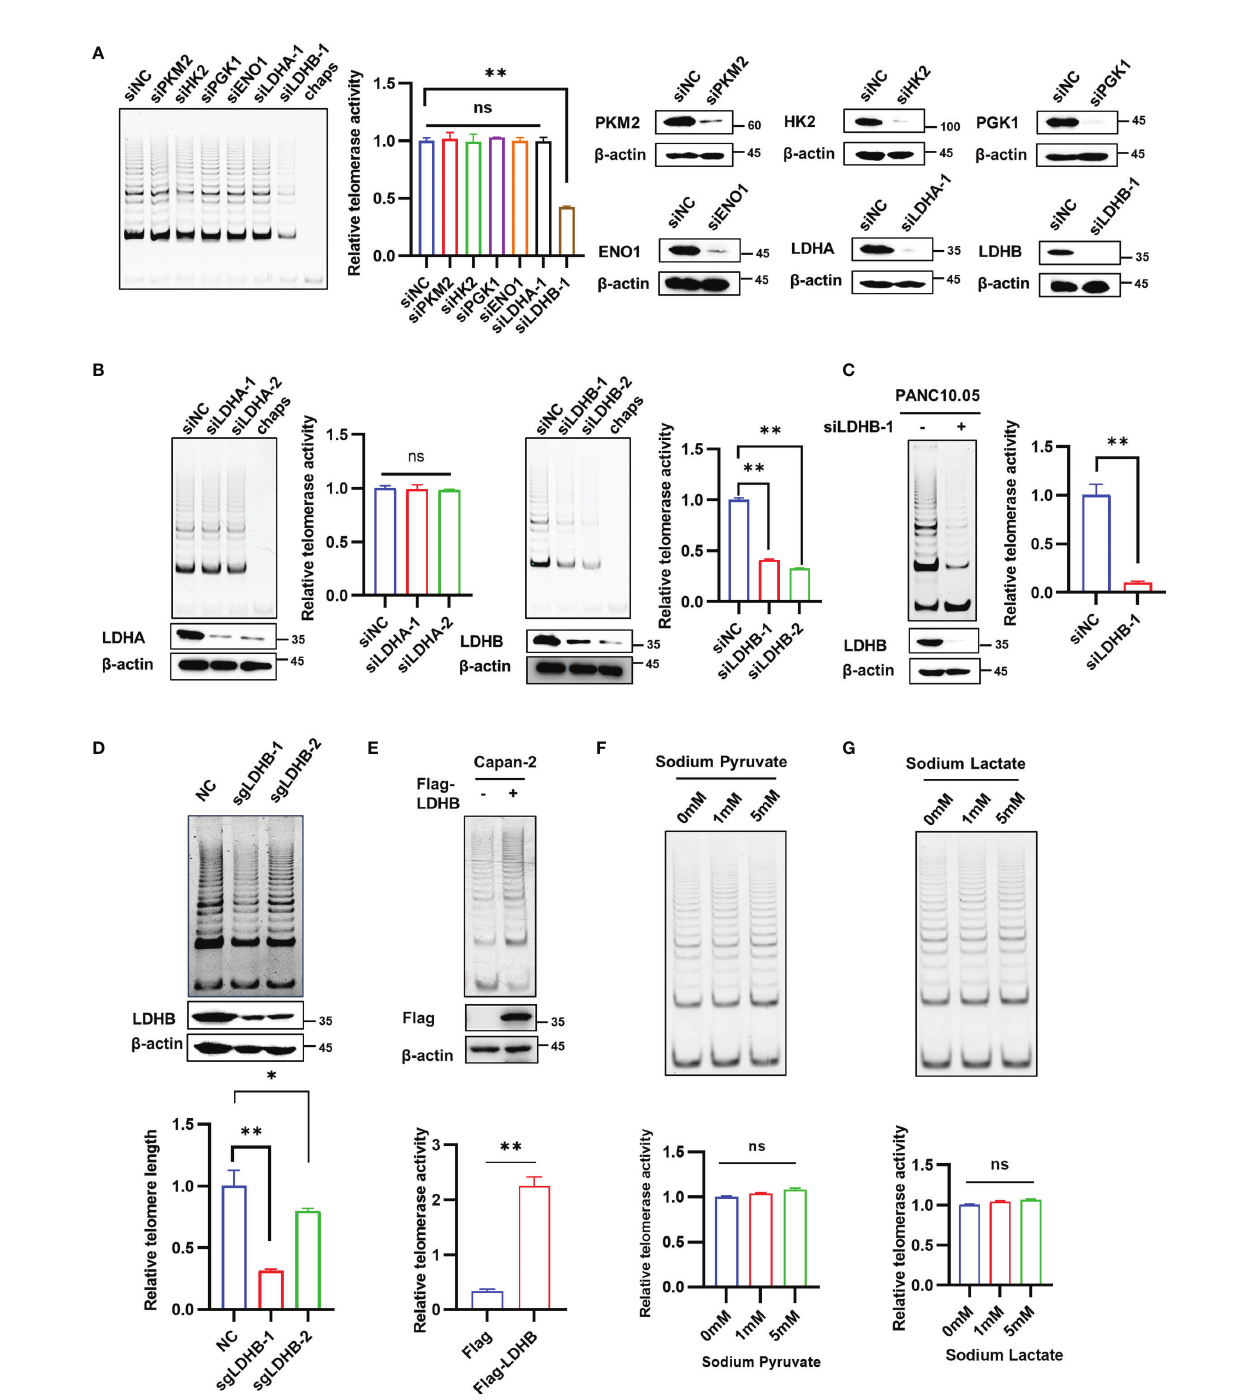
FIGURE 1 | LDHB regulates telomerase activity in pancreatic cancer cells independent of its regulation on metabolic pathways. (A) PANC-1 cells were transfected with indicated siRNAs for 2 days and TRAP assay was performed to detect telomerase activity. Western blot assay was performed to detect the knockdown effect of siRNA. (B) The telomerase activity of knockdown of LDHA or LDHB with two siRNAs were detected by TRAP assay in PANC-1 cells. The expression of LDHA or LDHB were detected by western blot with the indicated antibodies. (C) The telomerase activity of knockdown of LDHB was detected by TRAP assay in PANC10.05 cells. (D) PANC-1 cells were stably transfected with LDHB sgRNAs and telomerase activity was examined. (E) TRAP assay in Capan-2 cells transfected with Flag or Flag-LDHB. The expression of Flag-LDHB was detected by western blot. (F, G) PANC-1 cells were treated with indicated concentrations of sodium pyruvate (F) or sodium lactate (G) for 48 h and telomerase activity was detected. Data are shown as mean ± SD of three independent experiments. (*P<0.05, **P<0.01, ns means no statistically signi fi